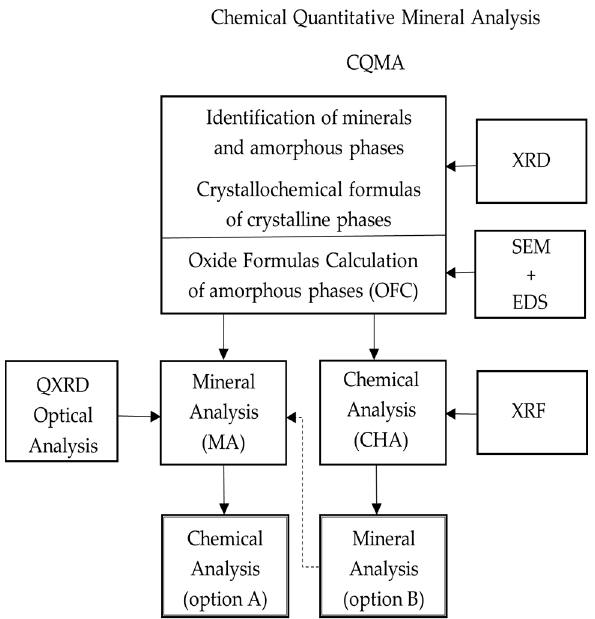
Figure 1. Simplified scheme of the chemical quantitative mineral analysis (CQMA) method for the calculation of bulk chemical composition from mineral analyses (option A) and for the calculation of minerals from bulk chemical analyses (option B). (Scheme is adopted from Klika et al. [33]). The oxides of elements were calculated from minerals (i.e., analytes c i,calc ) according to Equation (1) using the CQMA (option A) as: